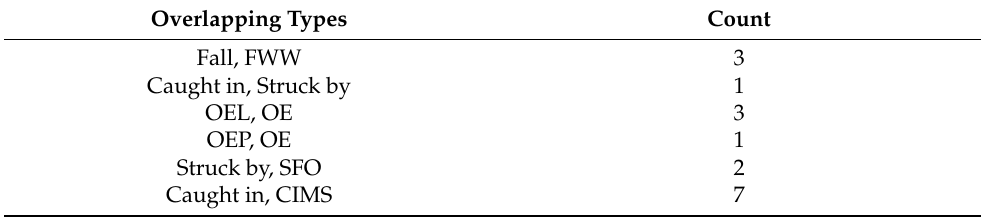
Table 9. Counts of overlapping accident